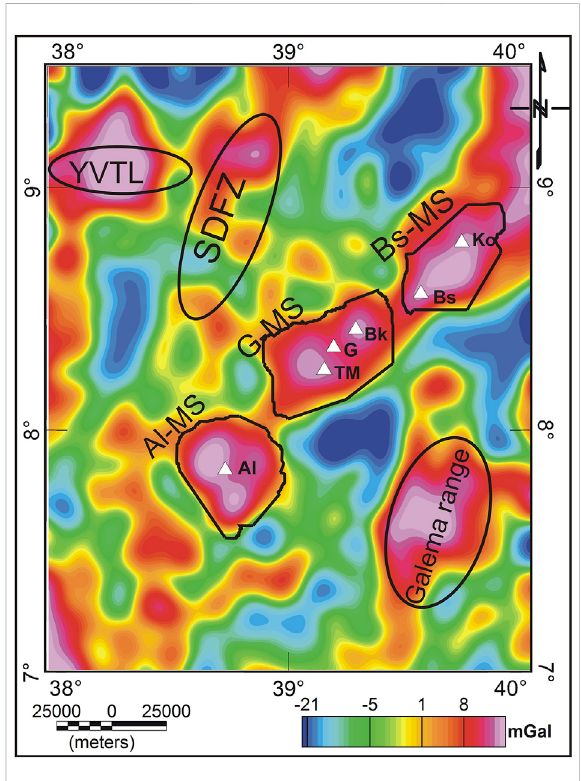
FIGURE 5 Bandpass fi ltered regional gravity anomaly map of the MER where wavelengths between 20 and 130 km are passed. The elliptical-shaped solid black lines are the off-rift volcanic regions (YVTZ, SDFZ, and Galema range). Labels: Al-MS, G-MS, and Bs-MS represent Aluto, Gedemsa, and Boseti magmatic segments respectively.